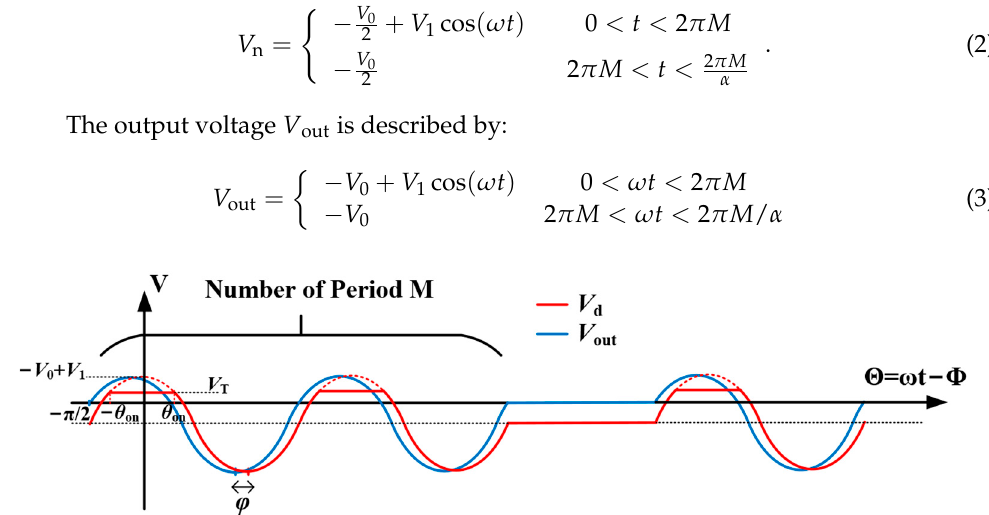
Figure 3. V d and V out in the time domain.